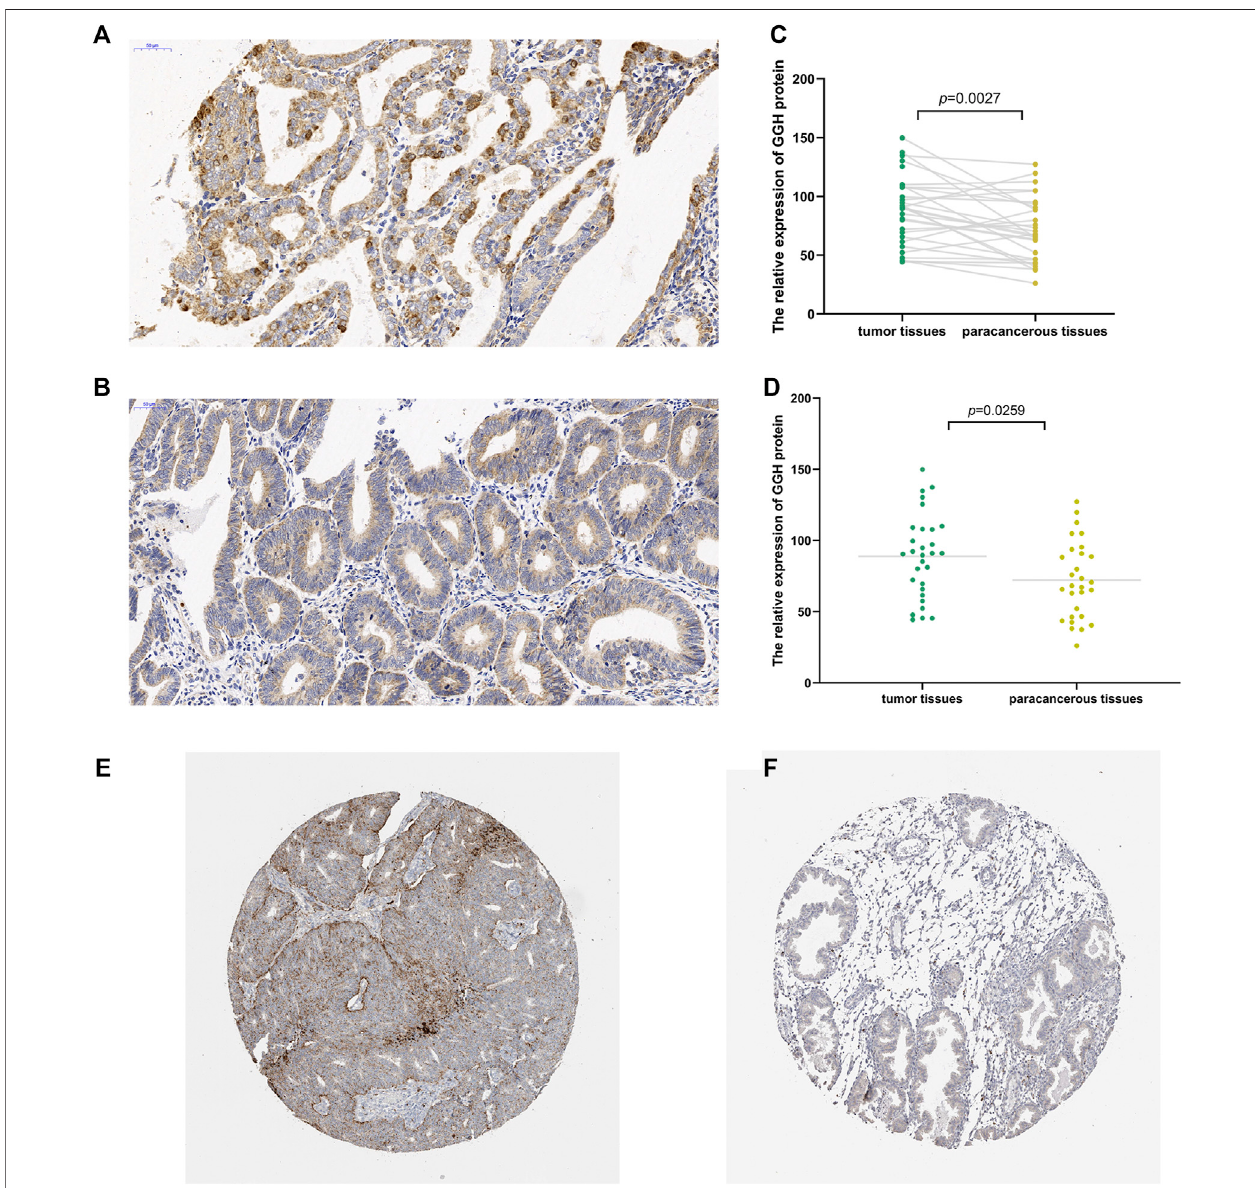
FIGURE1| ElevatedexpressionofGGHproteininUCECtumortissue. (A,B) ImmunoexpressionofGGHproteininUCECtumortissuesandpairedparacancerous tissue ( × 200 magni fi cation). (C,D) Comparisons of relative GGH protein expression in tumor tissues versus both paired and unpaired paracancerous tissues using H-scores. (E,F) Immunoexpression of GGH in UCEC tumor tissues and normal tissues from the Human Protein Atlas ( × 2 magni fi cation).